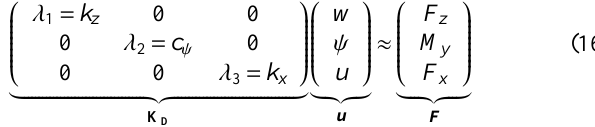
Fig. 4. Determination of instantaneous center of rotation P 01 , ( i ) of Figure 4. Determination of instantaneous center of rotation P 01 , ( i ) a flexure hinge of a flexure